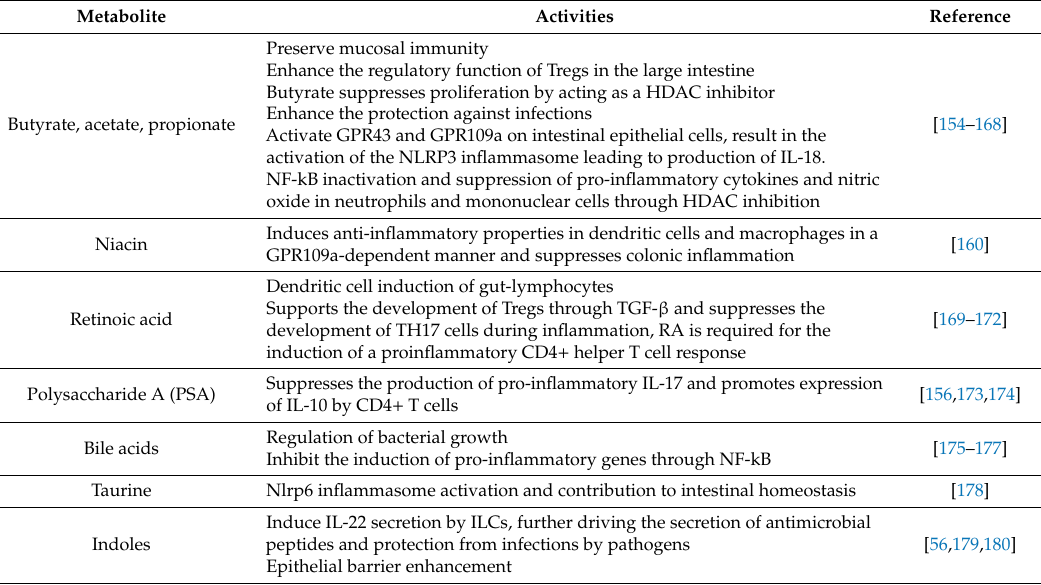
Table 3. Main postbiotic classes and their biological activities (adapted form 254).